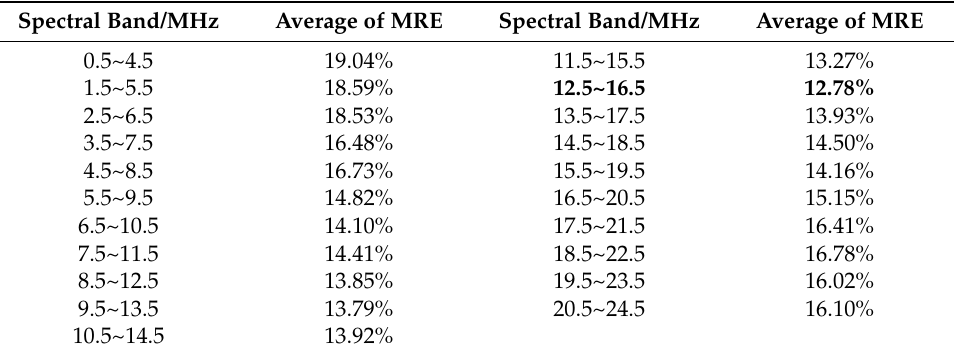
Table 2. Errors from the test set over different spectral bands.